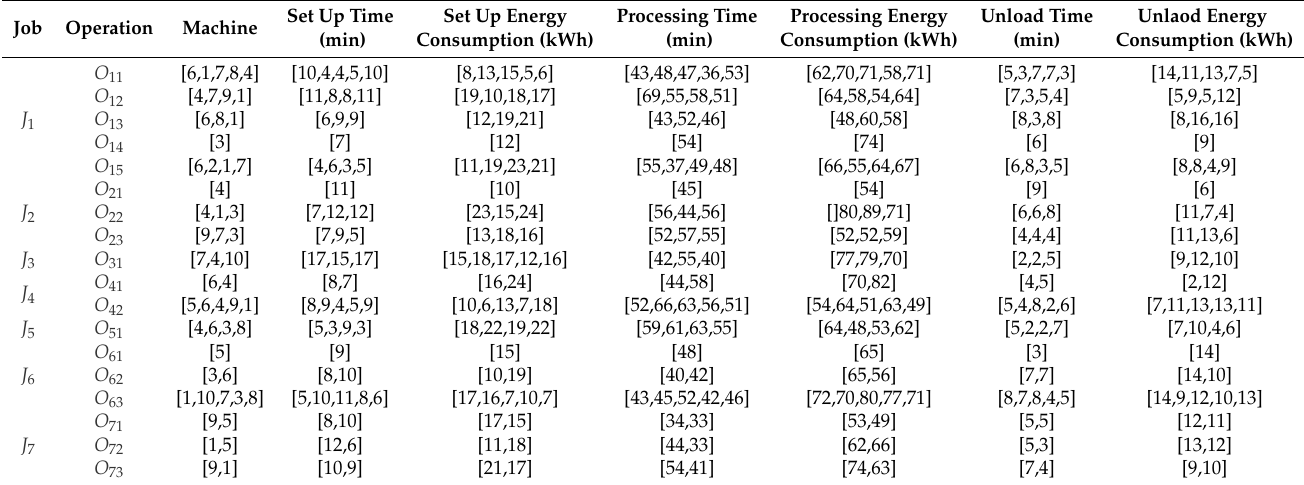
Table 7. The job shop information of Instance 1.